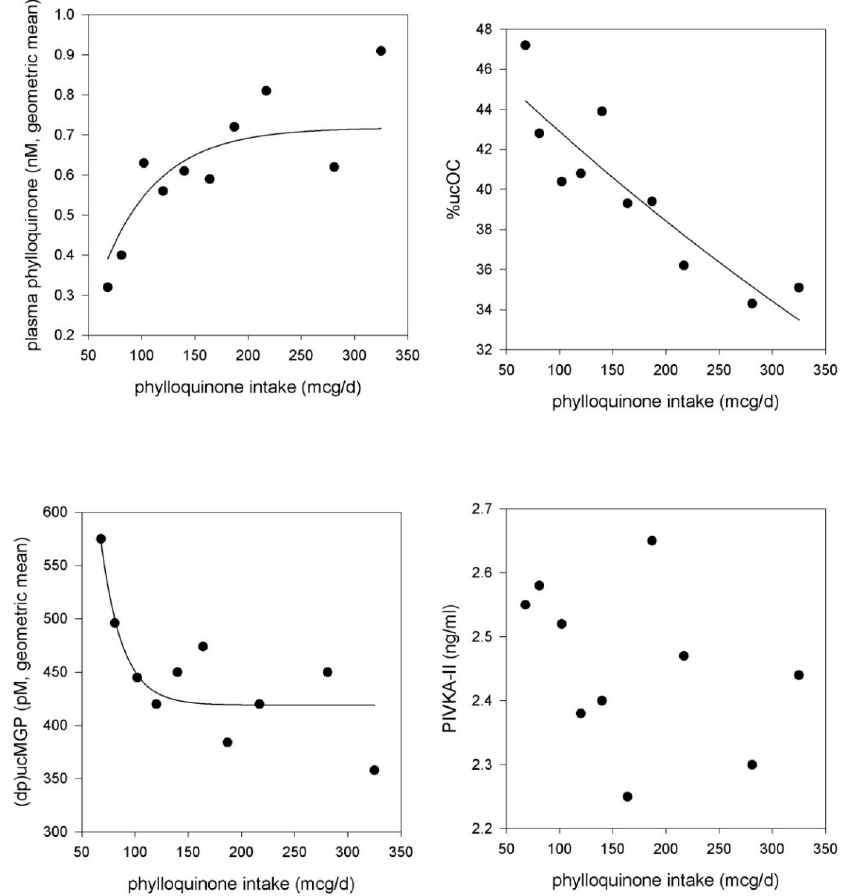
Figure 2. Association between food frequency questionnaire (FFQ)-estimated phylloquinone intake and circulating biomarkers of vitamin K status (at baseline) in community-dwelling older men and women participating in a phylloquinone supplementation trial [39,40]. The geometric mean of each biomarker is plotted at the median intake within each decile category. Adjustment was made for age, sex, BMI, energy intake (kcals/day), season, and triglycerides (for plasma phylloquinone).